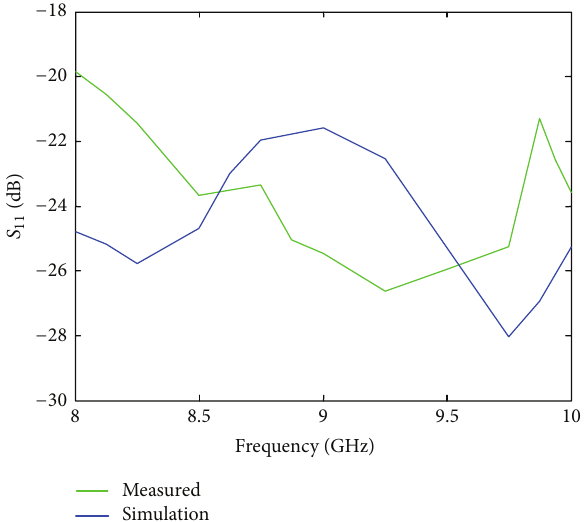
Figure 13: Reflection coefficient of simulated and measured